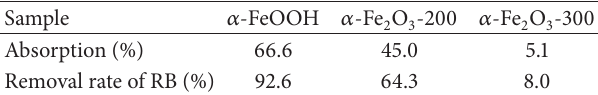
Table 2: Absorption and photodegradation rate of RB by different catalysts within 2